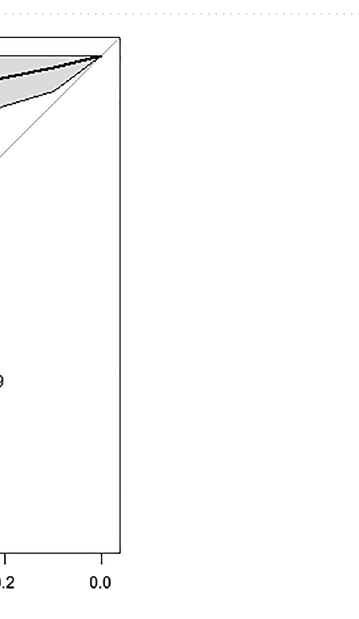
Figure 3. ROC curves of the integer score for the prediction of 1 and 4.4-years mortality in the derivation sample. ( A ) 1 year mortality. ( B ) 4.4 years mortality. The grey shape displays the 95% confidence interval of sensitivity. ROC receiver operating characteristics. AUC area under the curve. CI confidence interval. CI were computed using a boot-strap method.